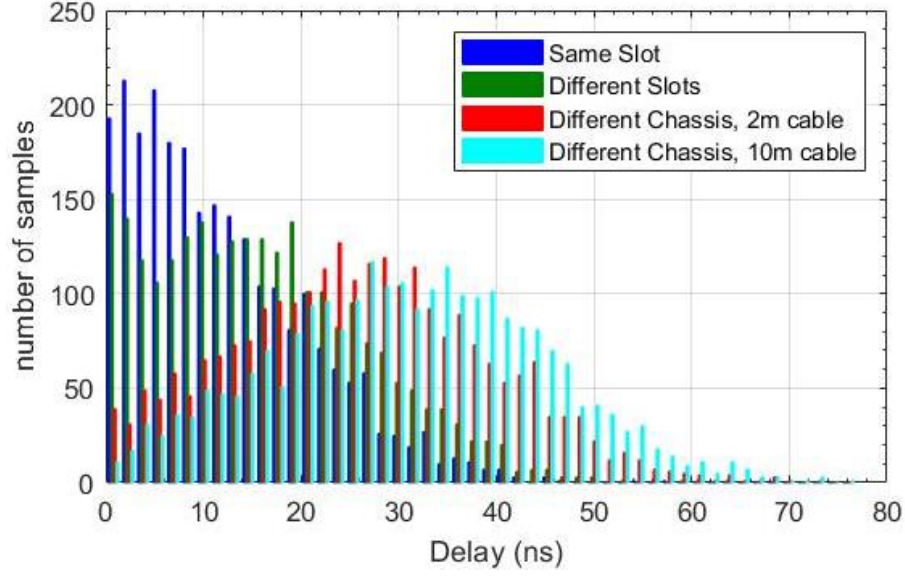
Figure 11. Histograms for phase measurements with SAR modules.